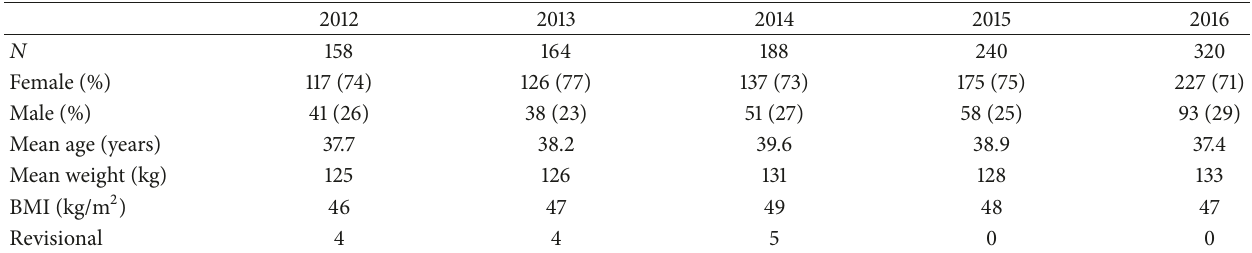
Table 1: Sleeve gastrectomy patient characteristics from 2012 to 2016.